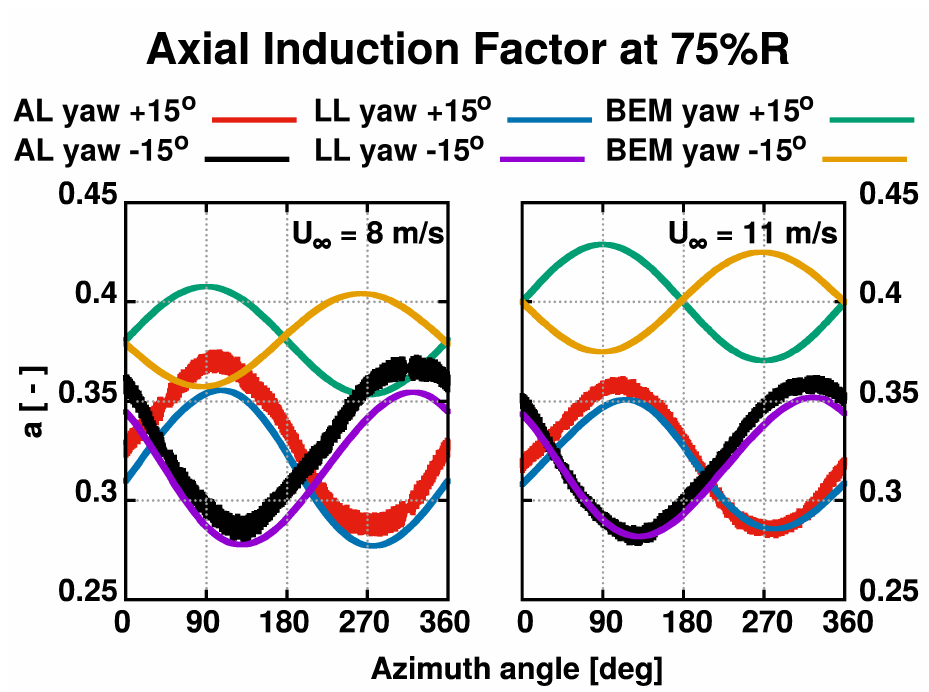
Figure 31. Axial induction factor at 75% R of the blade at 15 ◦ yawed wind speed at 8 and 11